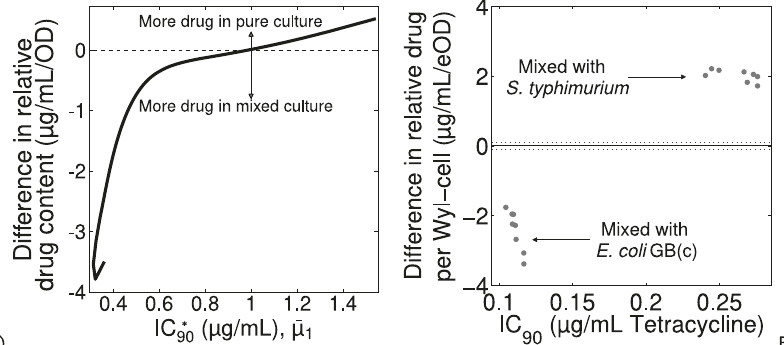
Fig. 3 Relative content in drug molecules changes as predicted by model. A Difference in drug content per S 1 -cell at the IC 90 between pure culture and mixed culture conditions. Positive and negative values denote more drug in S 1 -cells in pure and mixed culture conditions, respectively. Lack of difference is shown as a horizontal, dotted line. B Experimental estimation of the difference in relative cell content in the bacterium Escherichia coli Wyl. Raw data for Wyl is shown as red dots. Lack of difference is shown as a horizontal, black line and the 95% con fi dence of the lack of difference as a horizontal, dotted